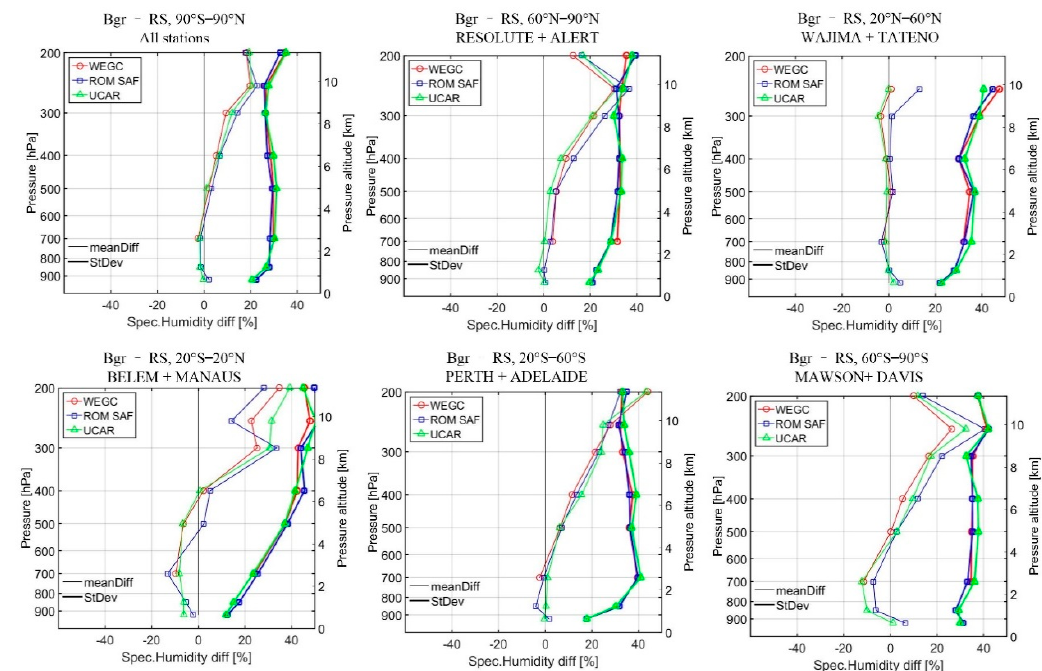
Figure 5. Specific humidity mean differences (meanDiff) and corresponding standard deviations (StDev) between background profiles and RS of WEGC, ROM SAF and UCAR over the period of 2007 to 2010 at the six latitudinal bands; the same as Figures 2–4.